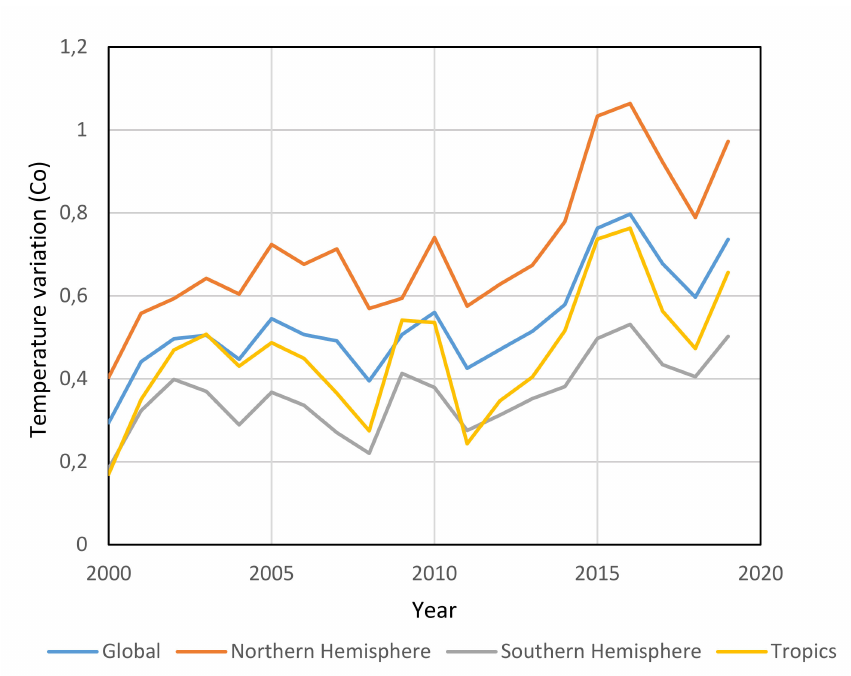
Figure 2. Median temperature variations at di ff erent locations